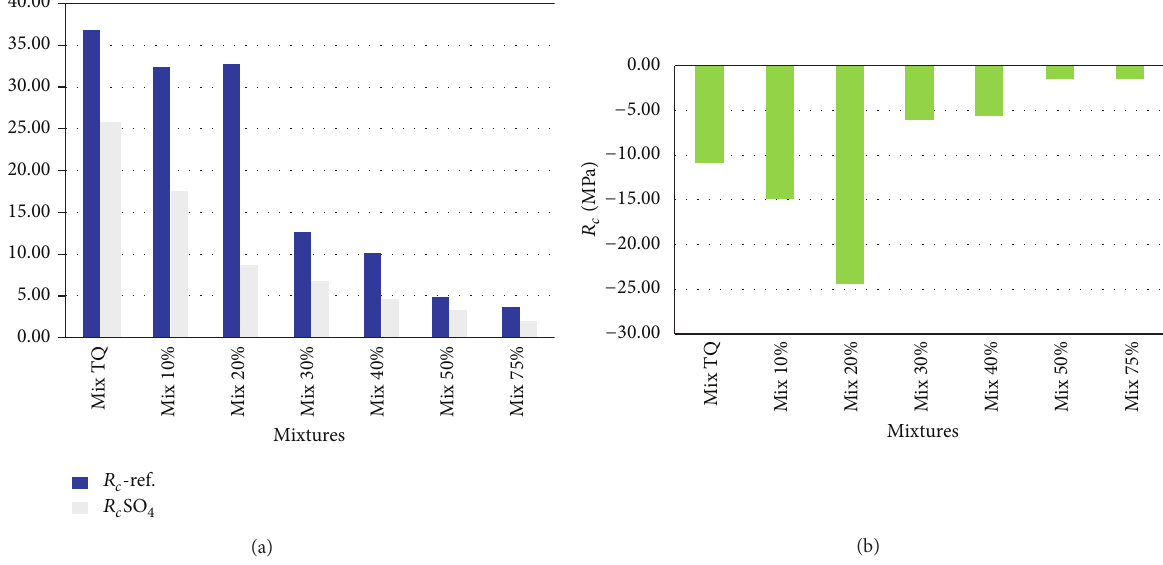
Figure 16: Exposure of rubber cement composites to sulfate attack: (a) compressive strength without and with sulfate attack; (b) loss of compressive